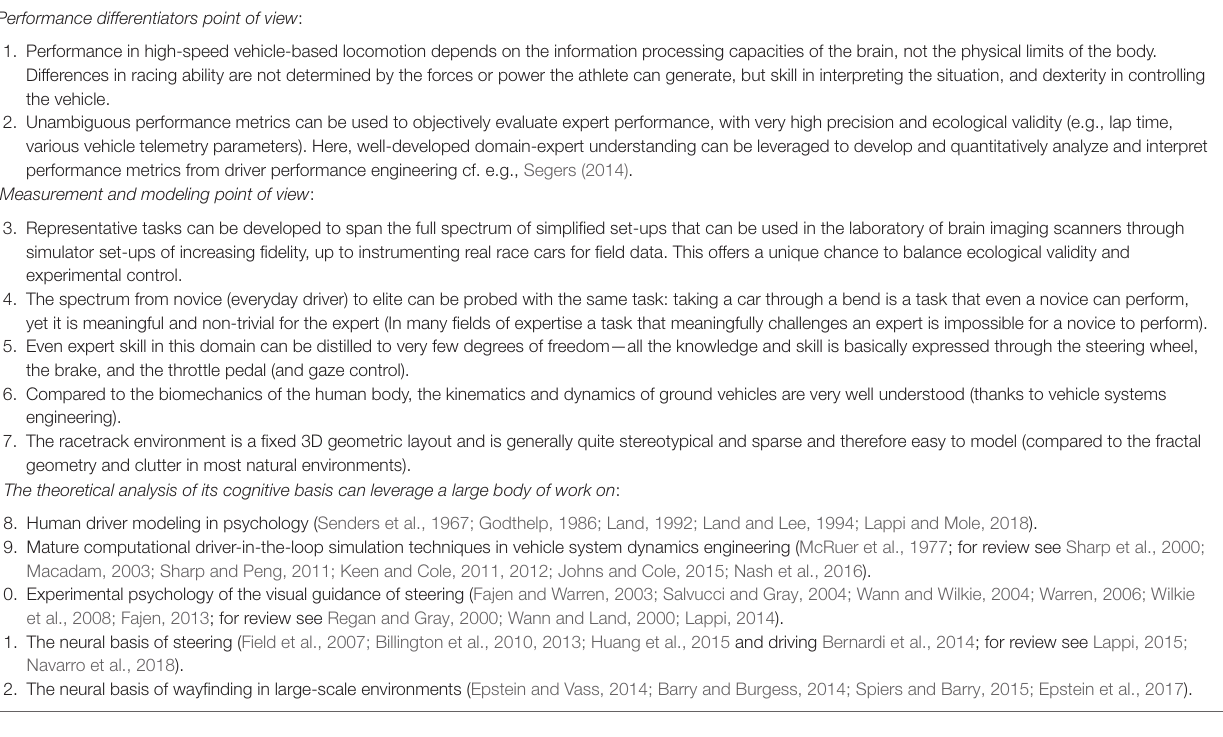
TABLE 1 | Twelve features of race driving that make it an excellent environment to study elite